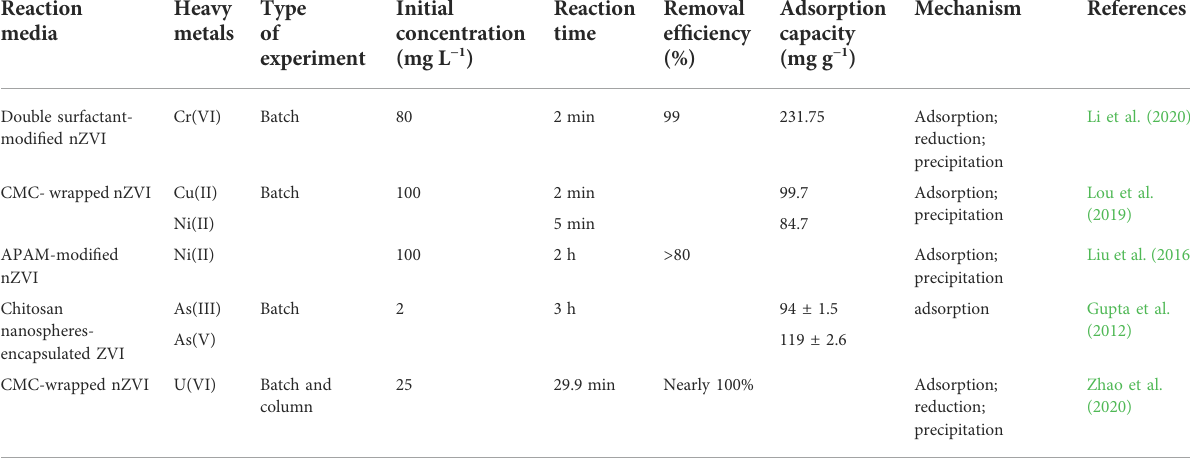
TABLE 5 Application of nZVI coated-material in PRB treatment of groundwater heavy metals. Reaction